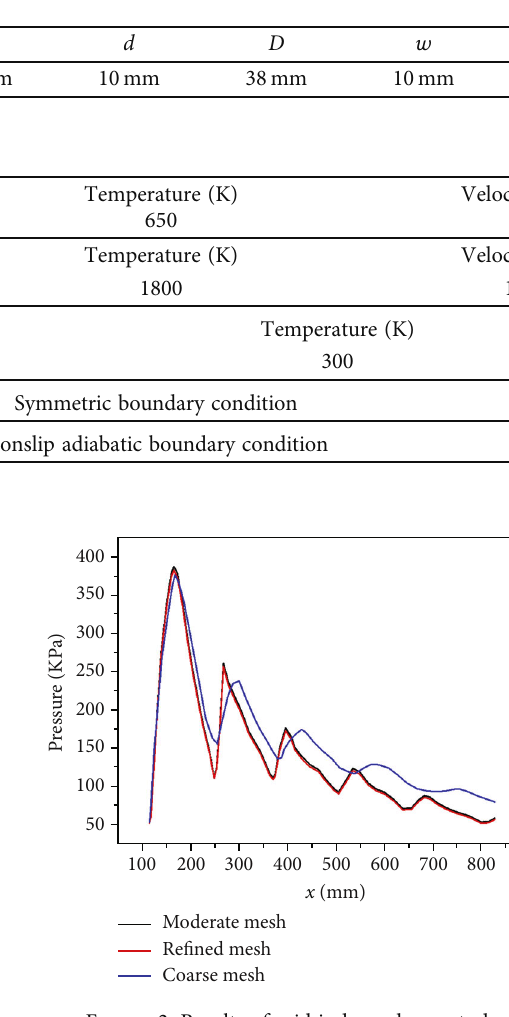
Figure 2: Results of grid independency study.